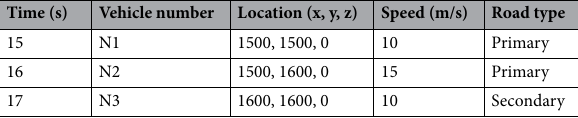
Table 1. Example of a group member table.